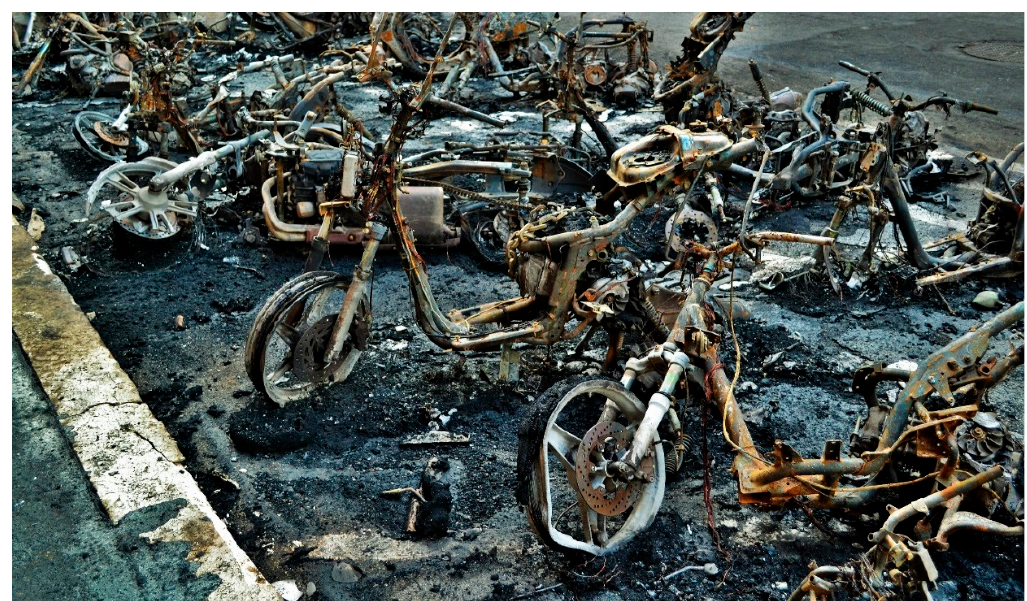
Figure 1. Vandali. Photo by Agricubismo ® . All figures are property of the author/artist and protected by copyright (Agricubismo®). www.agricubismo.com